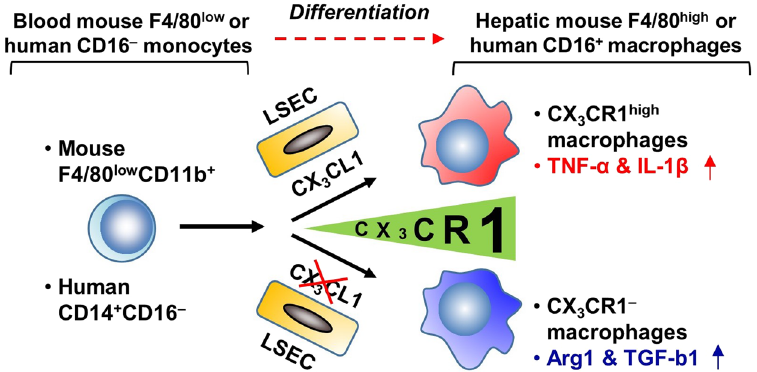
Figure 8. Schematic summary. CX 3 CR1 differentiates mouse monocytes (F4/80 low CD11b + ) and human monocytes (CD14 + CD16 − ) into pro-inflammatory macrophages. Liver sinusoidal endothelial cells (LSECs) express CX 3 CL1 in the